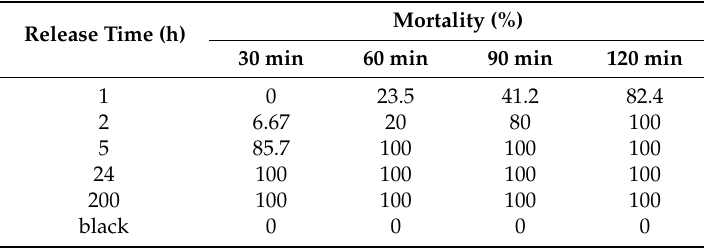
Table 1. The mortality rate of Schistosoma japonicum cercariae for the hydrogel release system